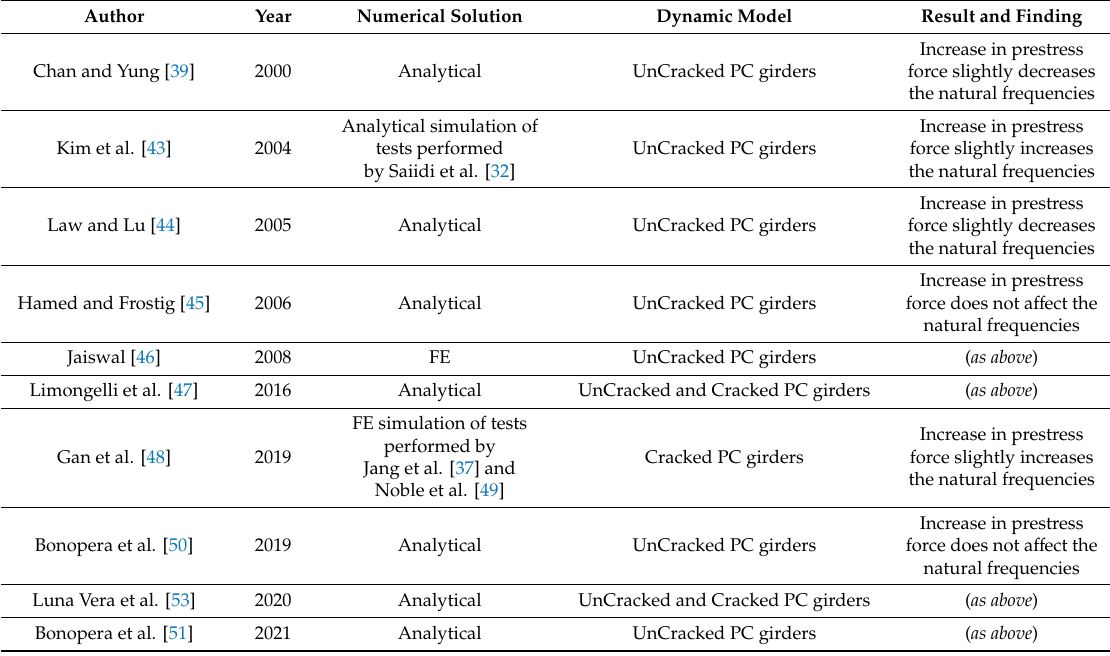
Table 2. Numerical investigations on the relation between prestress force and dynamics of PC girders.